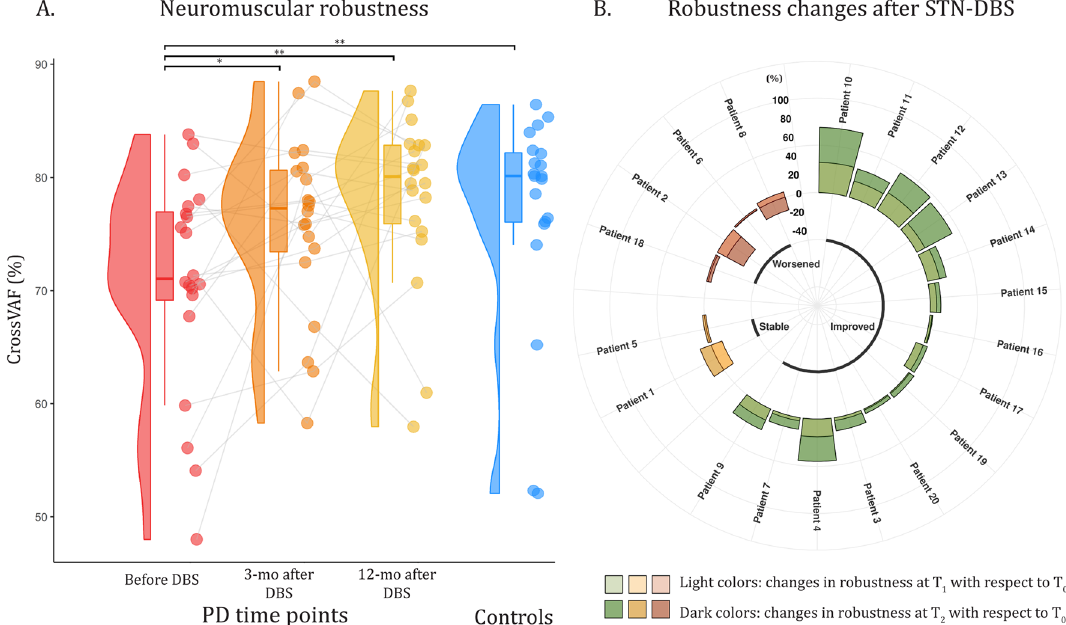
Figure 2. Panel ( A ) Raincloud plots of the neuromuscular robustness computed by means of the cross variance accounted For ( Cross VAF ) from PD patients before DBS (T 0 , in red), 3 months after DBS (T 1 , in orange), 12 months after DBS (T 2 , in yellow), and controls (in blue). For each group, the raincloud plot shows, sequentially, the data distribution (split-half violin plot), a standard visualization of central tendency with a boxplot (representing minimum, 25th percentile, median, 75th percentile, and maximum), and raw jittered data points of each specific individual (scatter plot). Panel ( B ) Circular bar diagram of the relative changes in muscle synergy robustness at 3 months after DBS with respect to baseline (T 1 –T 0 ), and at 12 months after DBS with respect to baseline (T 2 –T 0 ), for each PD patient. Green bars represent PD patients that improved the robustness of their motor control after DBS neurosurgery, yellow bars PD patients that did not change their robustness, and red bars PD patients that worsened their robustness after DBS neurosurgery. Single (*) and double (**) asterisks represent statistically significant differences with p -values lower than 0.05 and 0.01,